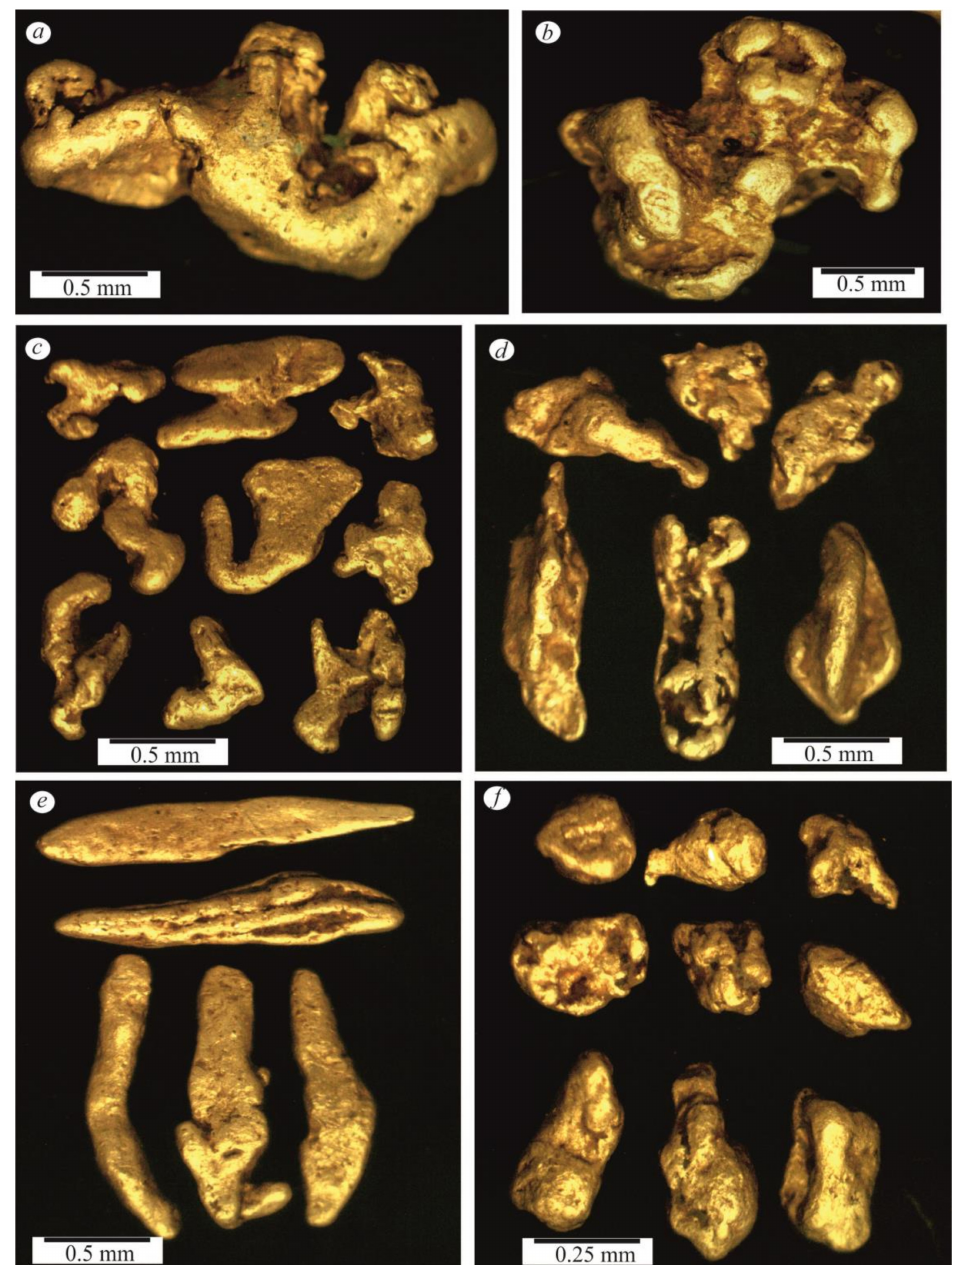
Figure 2. Morphology of native gold from the Borosku Unguokhtakh Creek: ( a , b ) ore-like, fractions of + 1 mm; ( c ) poorly rounded, fractions of 0.5–1 mm; ( d ) cloddy–angular, elongated dendritic, fractions of 0.5–1 mm; ( e ) wiry, fractions of 0.5–1 mm; ( f ) cloddy, cloddy–angular, fractions of 0.25–0.5